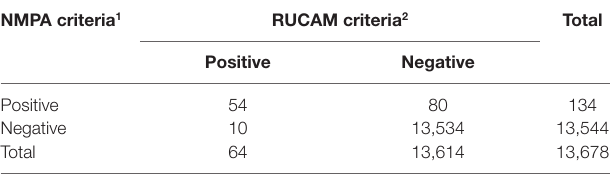
TABLE 5 | Agreement between the RUCAM criteria and NMPA criteria.